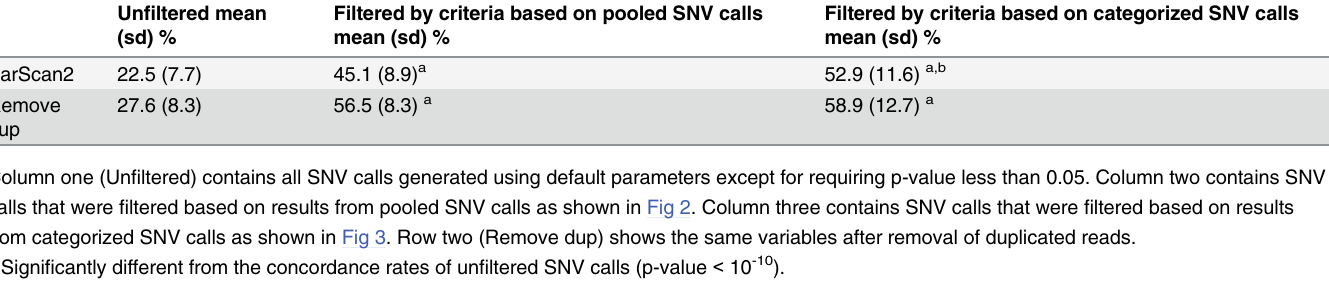
Filtered by criteria based on categorized SNV calls mean (sd) %